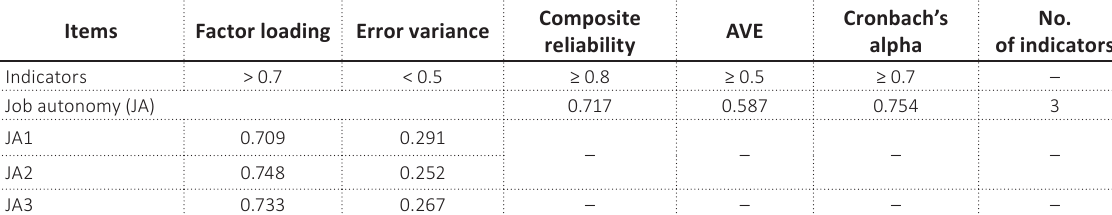
Table 1. Factor loading for job autonomy in the selected Nigerian banks